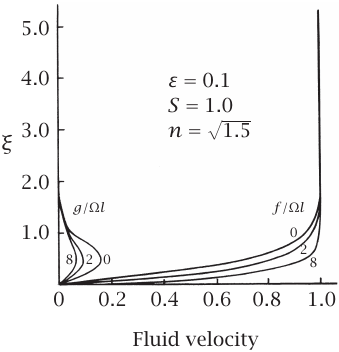
Figure 3.5 . Variations of f/ Ω l and g/ Ω l for different values of A , the mag- nitude of fluctuation in suction velocity.